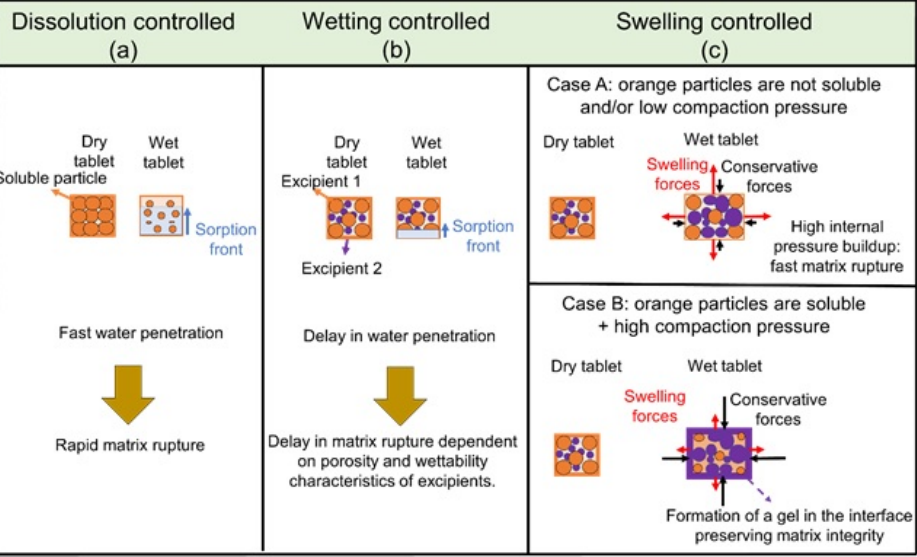
Figure 4. Schematics of disintegration mechanisms as affected by formulation characteristics for immediate ‐ release tablets: (a) Dissolution controlled disintegration regime whereby rapid dissolving excipient particles contribute to faster liquid sorption (blue arrowhead) and rapid disintegration onset, (b) Wetting controlled regime whereby the disintegration onset is limited by excipient wettability and tablet porosity, and (c) Swelling controlled regime whereby the disintegration onset is limited by excipient solubility and overall tablet strength. The black arrowheads in the swelling controlled regime (c) indicate conservative forces withholding the tablet while the red arrowhead indicates the dissipative forces (swelling force in this case) triggering disintegration onset.